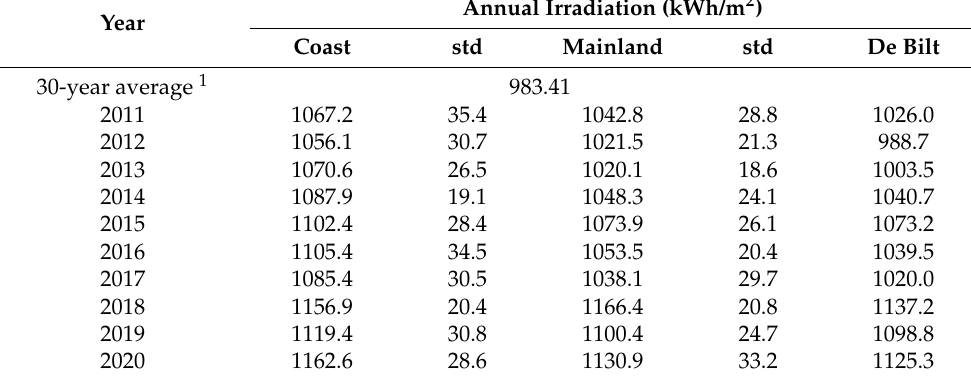
Table A1. Spatio-temporal variation of measured annual irradiation (kWh/m 2 ) and its standard deviation (std) in the Netherlands, comparing coast, mainland and the central De Bilt location. The coast column contains averaged irradiation values of 12 stations (blue dots in Figure 1) collected over 10 years. Similarly, the mainland irradiation values were obtained from 18 stations away from the coast (red dots in Figure